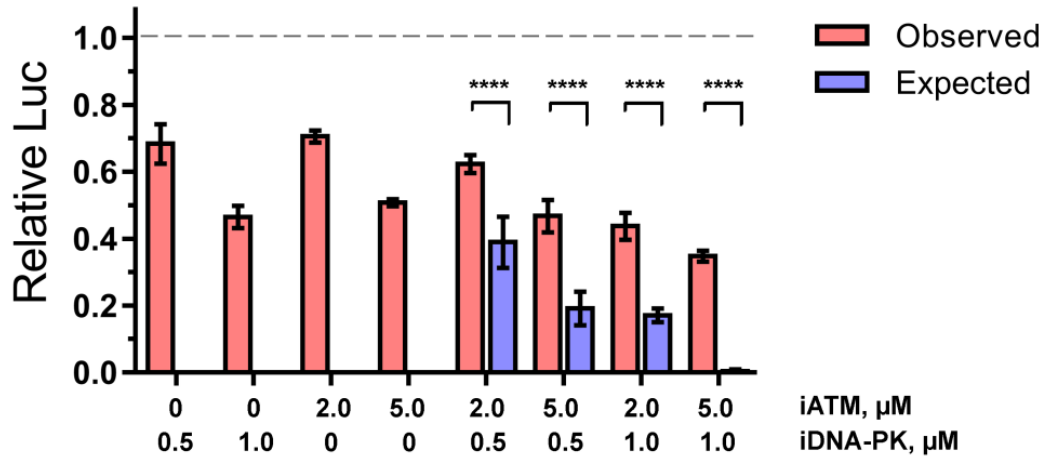
Figure 5. The inhibitory effect of iATM, iDNA-PK or its combinations on luciferase activity of HIV_wt in 293T cells normalized to cell viability (MTT-test). The expected inhibition efficiency was